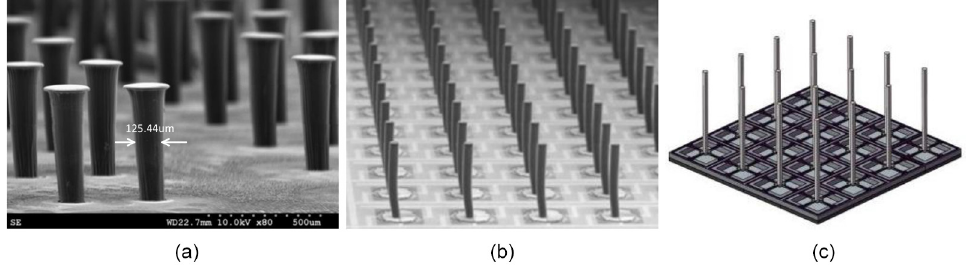
Fig. 1. Biomimetic sensors based on a bionic cilium.